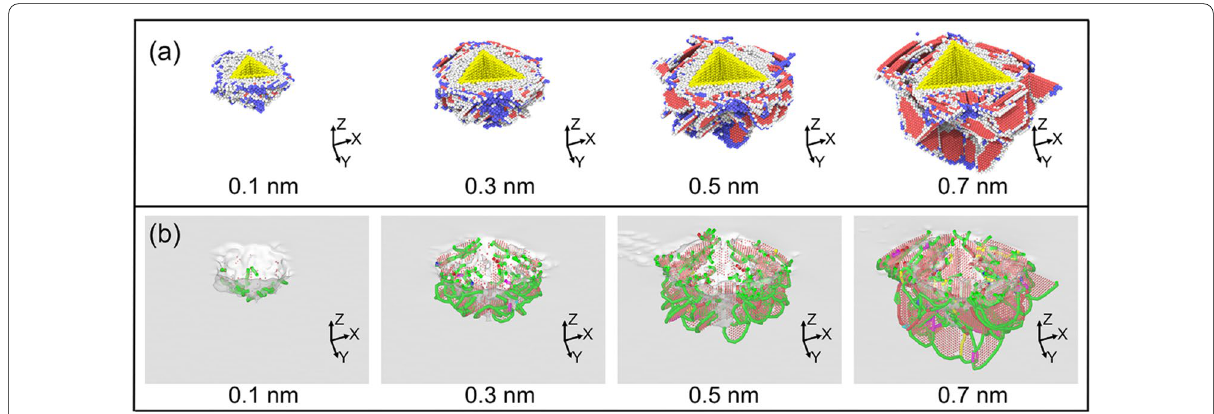
Fig. 5 Dislocation structures generated in Single-Indenter indentation process a CNA images of workpiece, b DXA images of